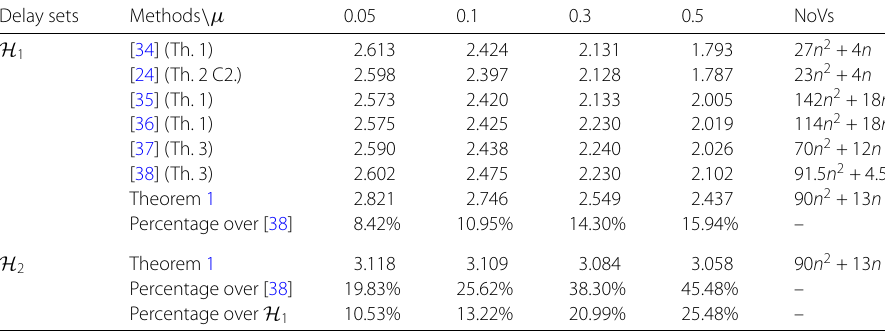
Table 1 MAUB s h under different μ for Example 1 Delay sets Methods \